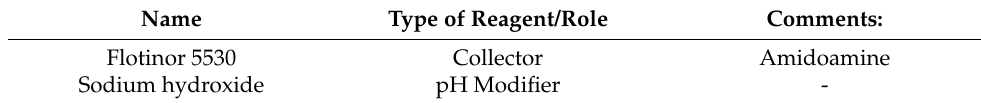
Table 1. Summary of all the reagents used in the experimental